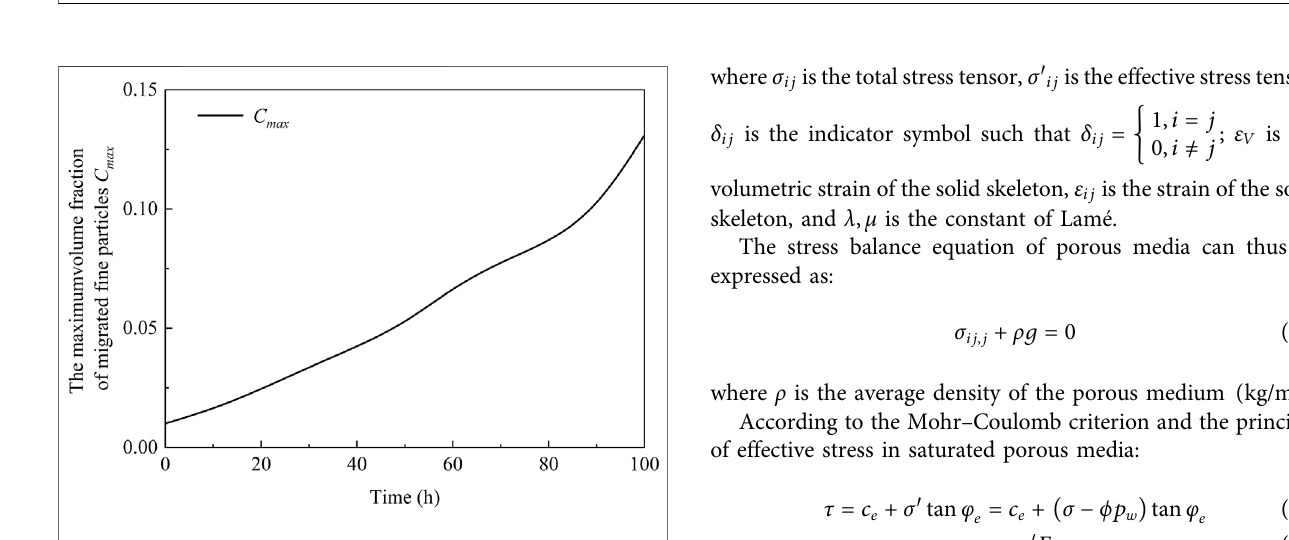
FIGURE 8 | Evolution curve of the maximum migrated fi ne particles volume